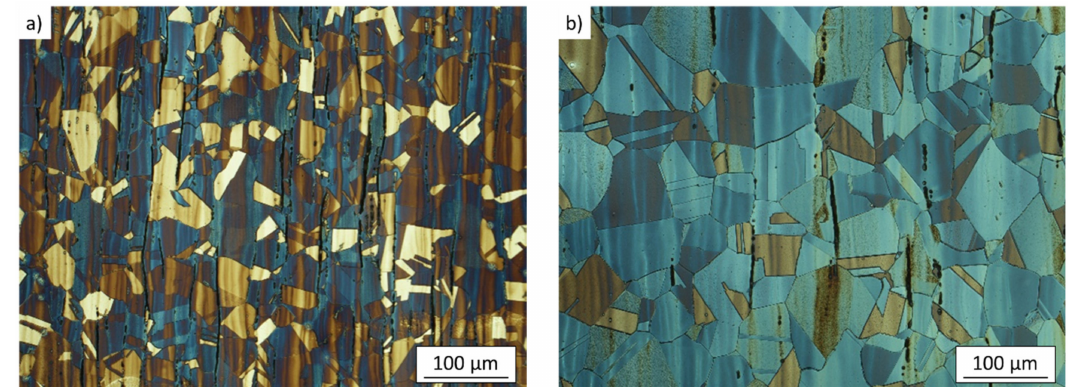
Figure 2. Microstructure of experimental material AISI 304L; ( a ) as-received state, ( b ) solution-annealed state. The rolling direction is oriented vertically. The dark stringers along the rolling direction are delta ferrite grains.